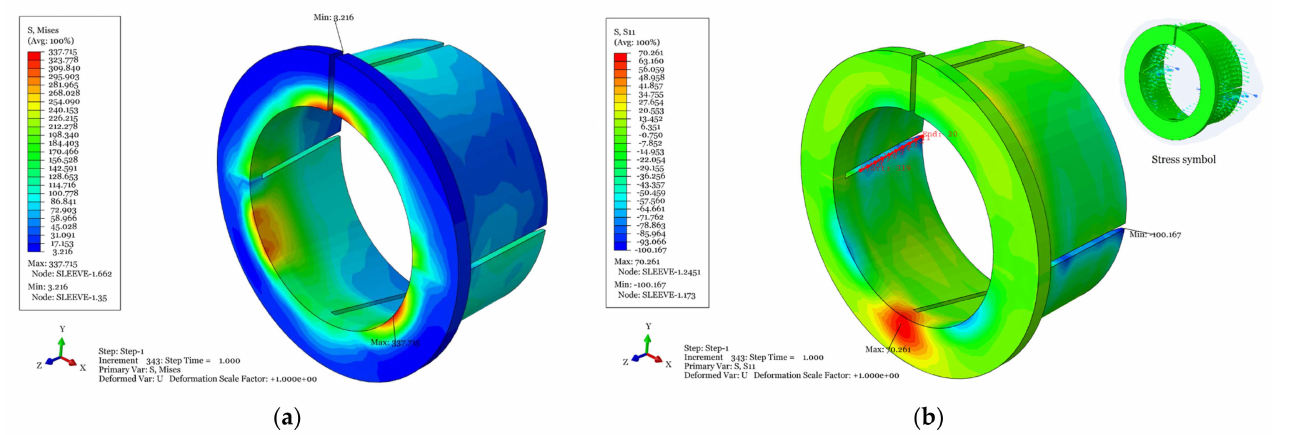
Figure 8. Stresses in sleeve resulted from 200 Nm torque. ( a ) von Mises stress distribution in sleeve